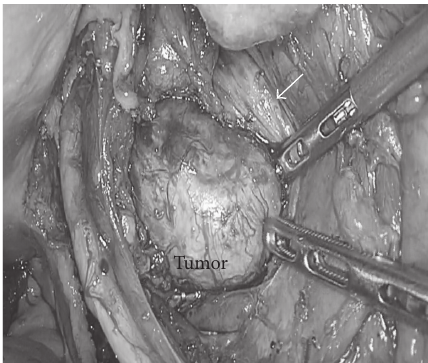
Figure 2: The tumor located at the dorsal side of the right sciatic nerve (arrow). The tumor originating from the right sciatic nerve.